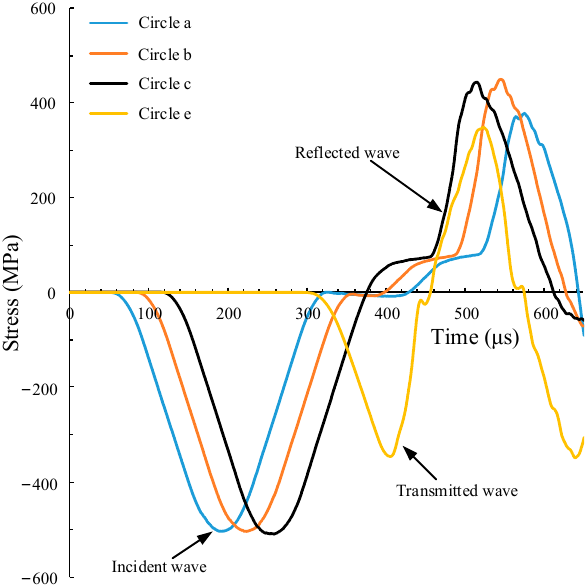
Figure 4. Stress waves recorded on the Hopkinson bars.